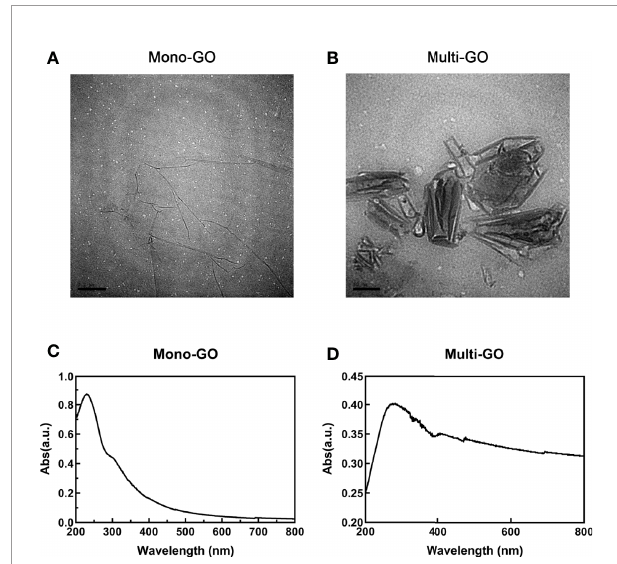
FIGURE 1 | Characterization of mono – graphene oxide (GO) and multi-GO. (A) Transmission electron microscope (TEM) image of multi-GO. Scale bar: 100 nm; (B) TEM image of mono-GO. Scale bar: 200 nm; (C) UV-Vis spectrum of multi-GO; (D) UV-Vis spectrum of